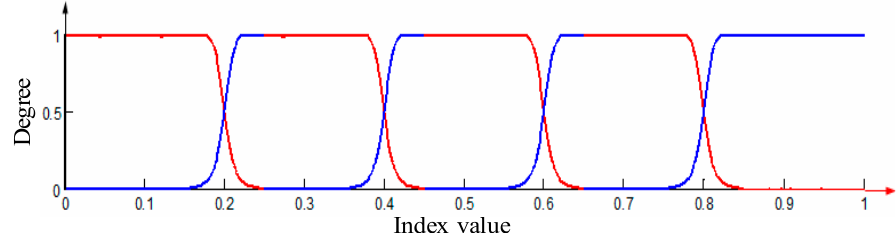
Figure 2. The curve of Cauchy membership function.